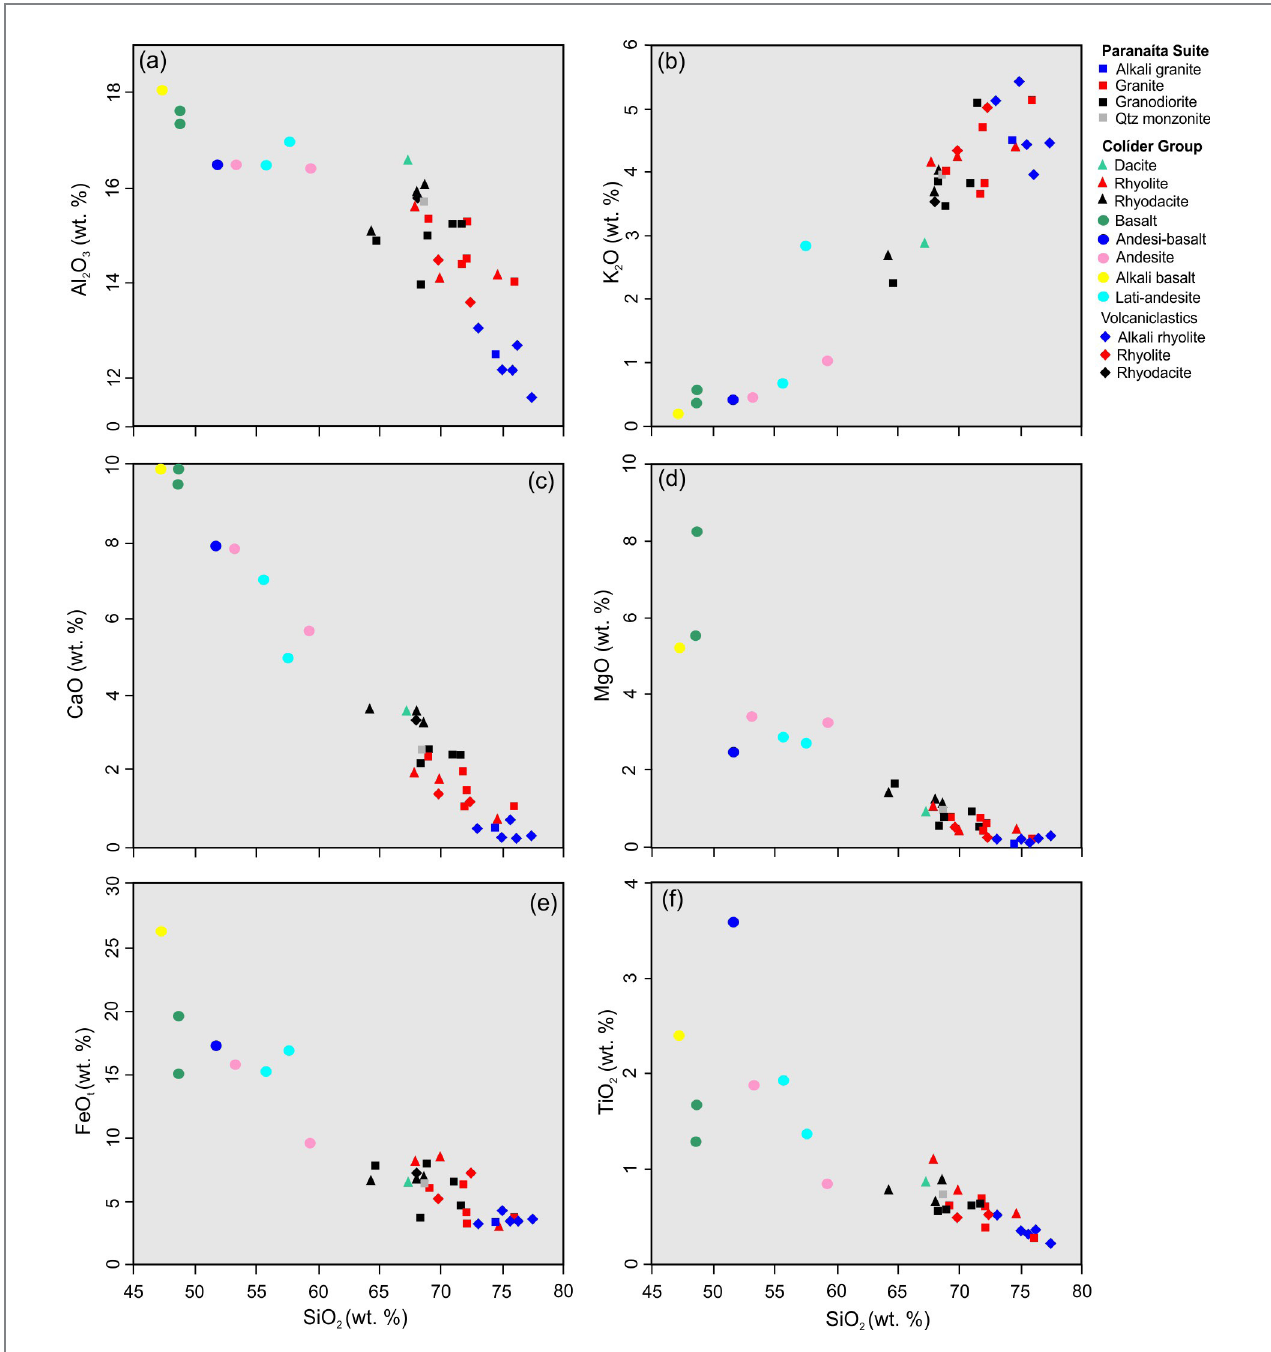
FIGURE 5 - Major- and trace-element Harker’s variation diagrams of rocks from the Colíder Group and Paranaíta Intrusive